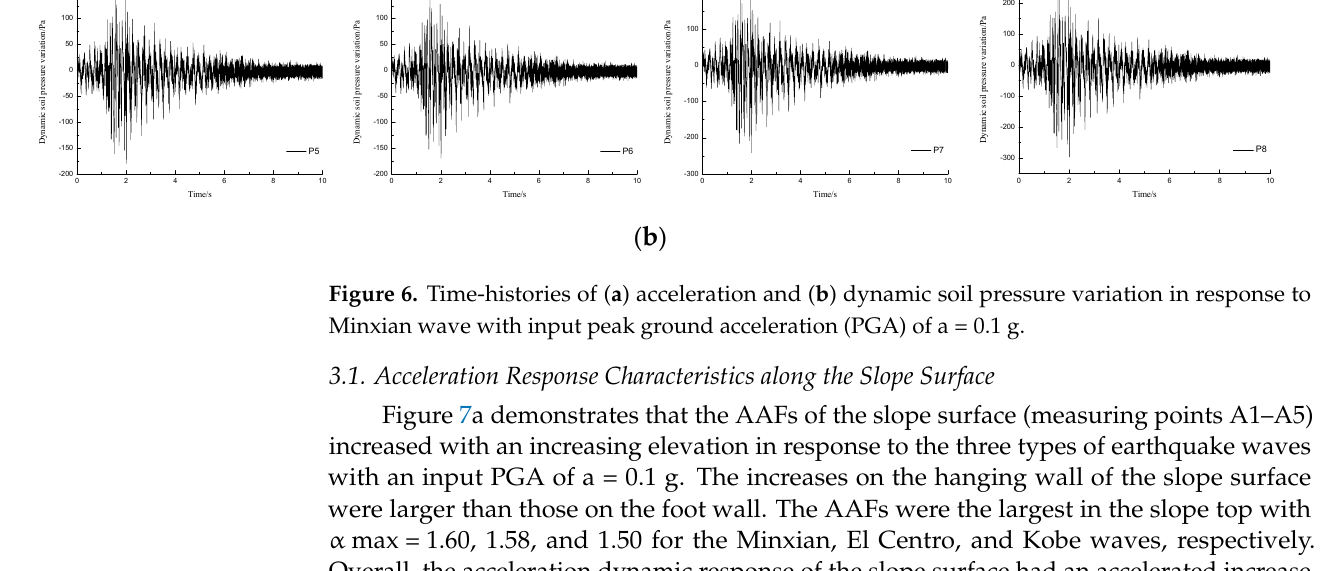
structure of the slope changed. Subsequently, the loading of the Kobe wave to the same level had little influence on the structure, and the AAFs decreased.